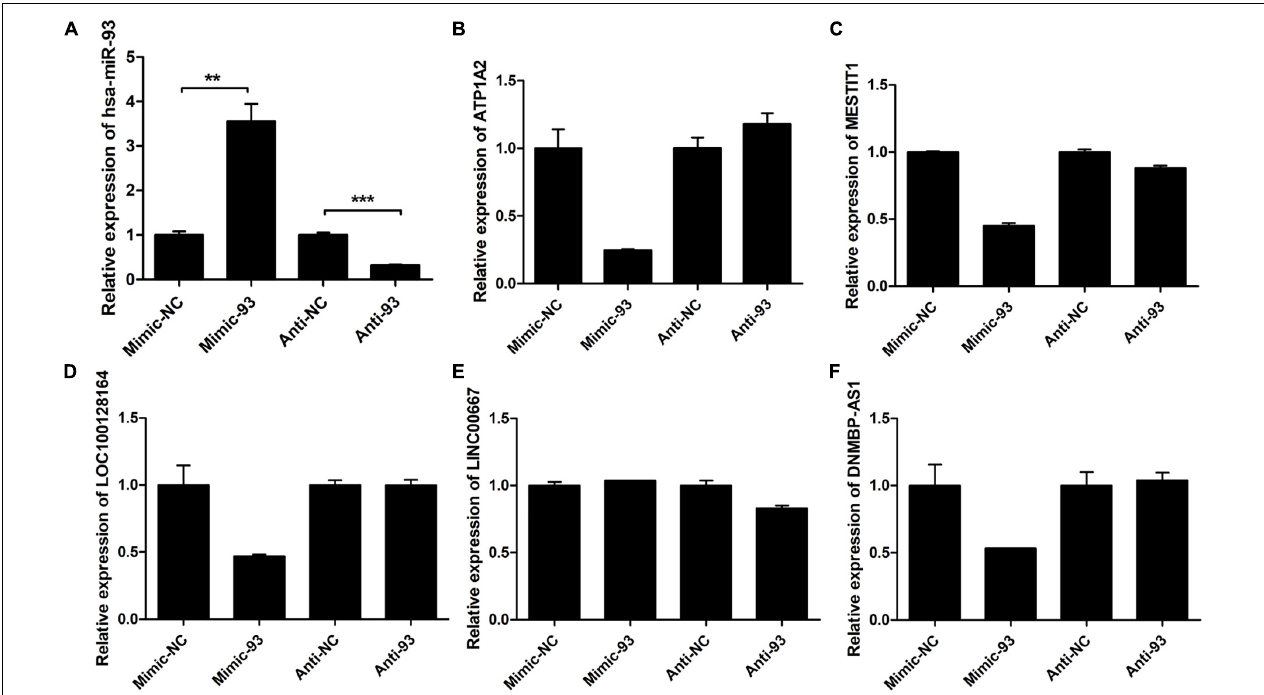
FIGURE 8 | The expression levels of miR-93-5P and some mRNA and lncRNAs. (A) Expression of miR-93-5P was examined by qRT-PCR 48 h post-transfection with miR-93-5p mimic/inhibitor or control. U6 gene was used as internal control. (B) ATP1A2, (C) MESTIT1, (D) LOC100128164, (E) LINC00667, (F)